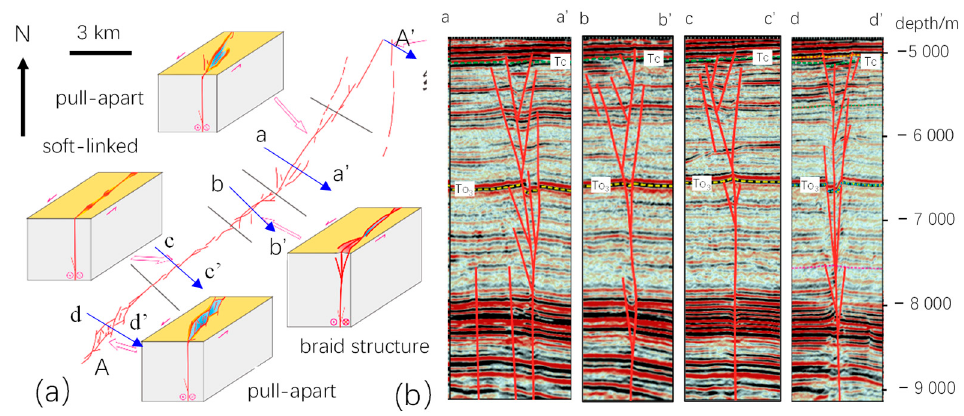
Figure 2. ( a ) The fault network and structure models at the top Ordovician carbonate and ( b ) typical seismic sections in well M1 area of the Fuman Oilfield (A-A’ showing fault location in Figure 1a; a-a’, bb’, cc’, dd’ showing the locations of the seismic sections; Tc: base of Carboniferous; To 3 : base of Upper Ordovician).